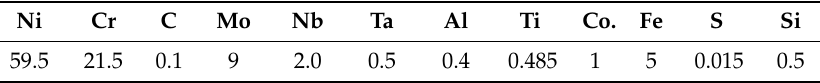
Table 1. Chemical composition of Inconel 625 alloy, wt